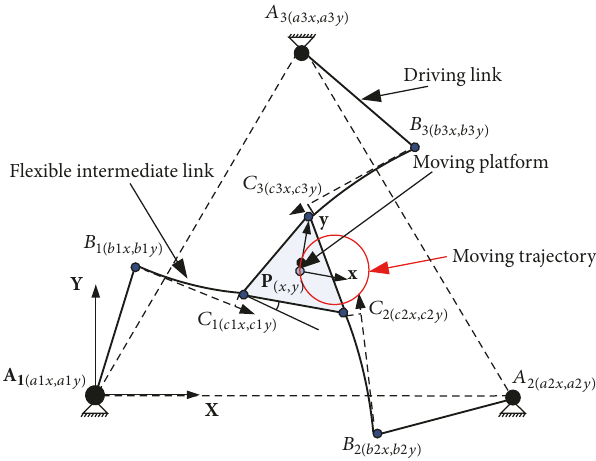
Figure 1: The structure diagram of the planar 3-RRR